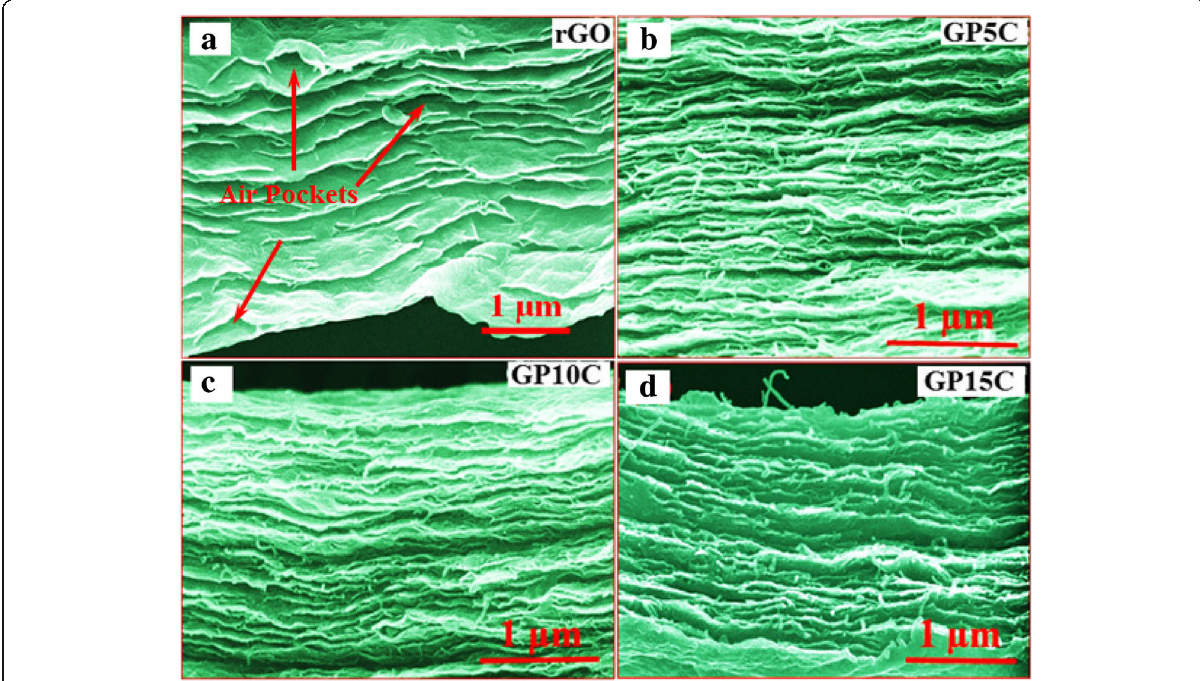
Fig. 4 Cross-sectional FE-SEM images of a rGO film, with different MWCNTs loading b 5 wt.%, c 10 wt.%, and d 15